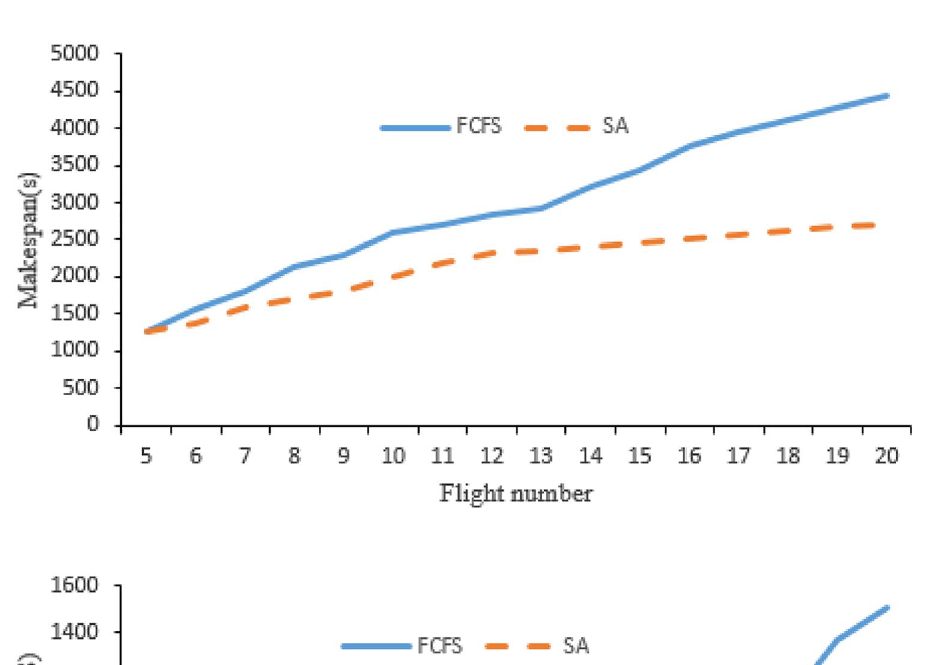
Fig. 7 The makespan of FCFS and SA